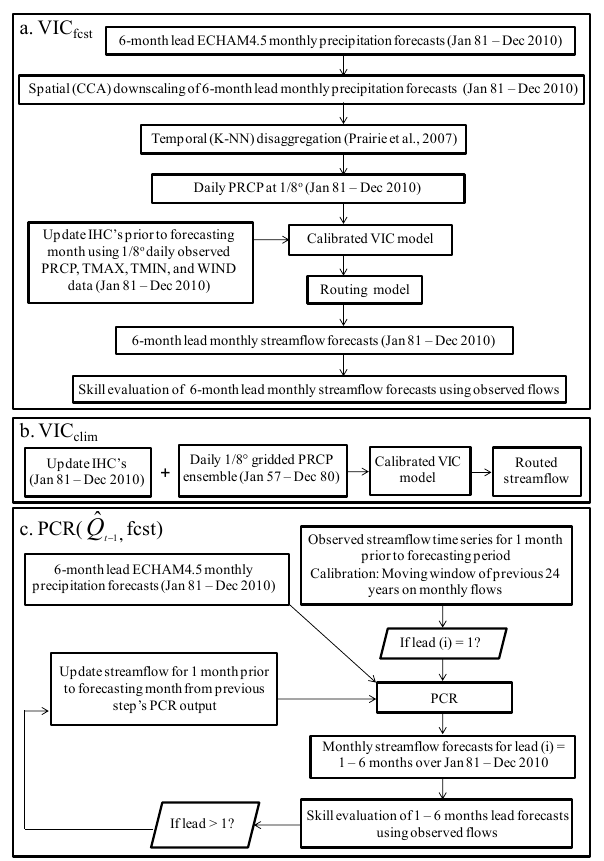
Fig. 2. Experimental design to develop monthly updated 6- month ahead monthly streamflow: (a) VIC fcst , (b) VIC clim , and (c) PCR( ˆ Q t − 1 , fcst). CCA refers to Canonical Correlation Analy- sis and K-NN represents Kernel-Nearest Neighbor approach. PRCP refers to precipitation, TMAX to maximum air temperature, TMIN to minimum air temperature, and WIND to wind speed.